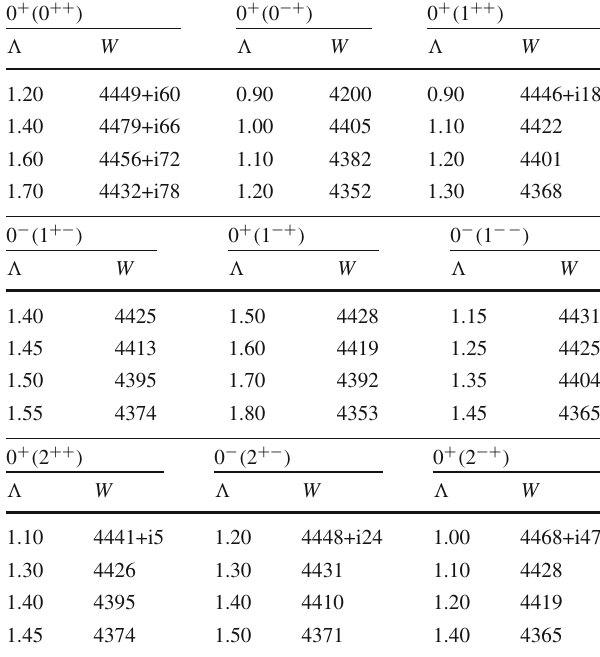
Table 1 The bound states from the D ∗ ¯ D 1 interaction with typical cut- offs (cid:16) . The cutoff (cid:16) and energy W are in units of GeV, and MeV, respectively